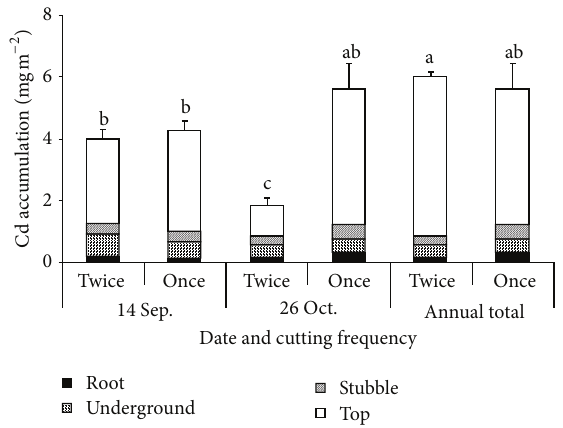
Figure 4: Cadmium (Cd) accumulation of Napiergrass following the first and second cuts from plots after a single (Once) or two cuttings (Twice). Mean ± standard deviation ( 𝑛 = 3 ). Figures with the same letter were not significantly different at 𝑃 < 0.05 based on LSD test.